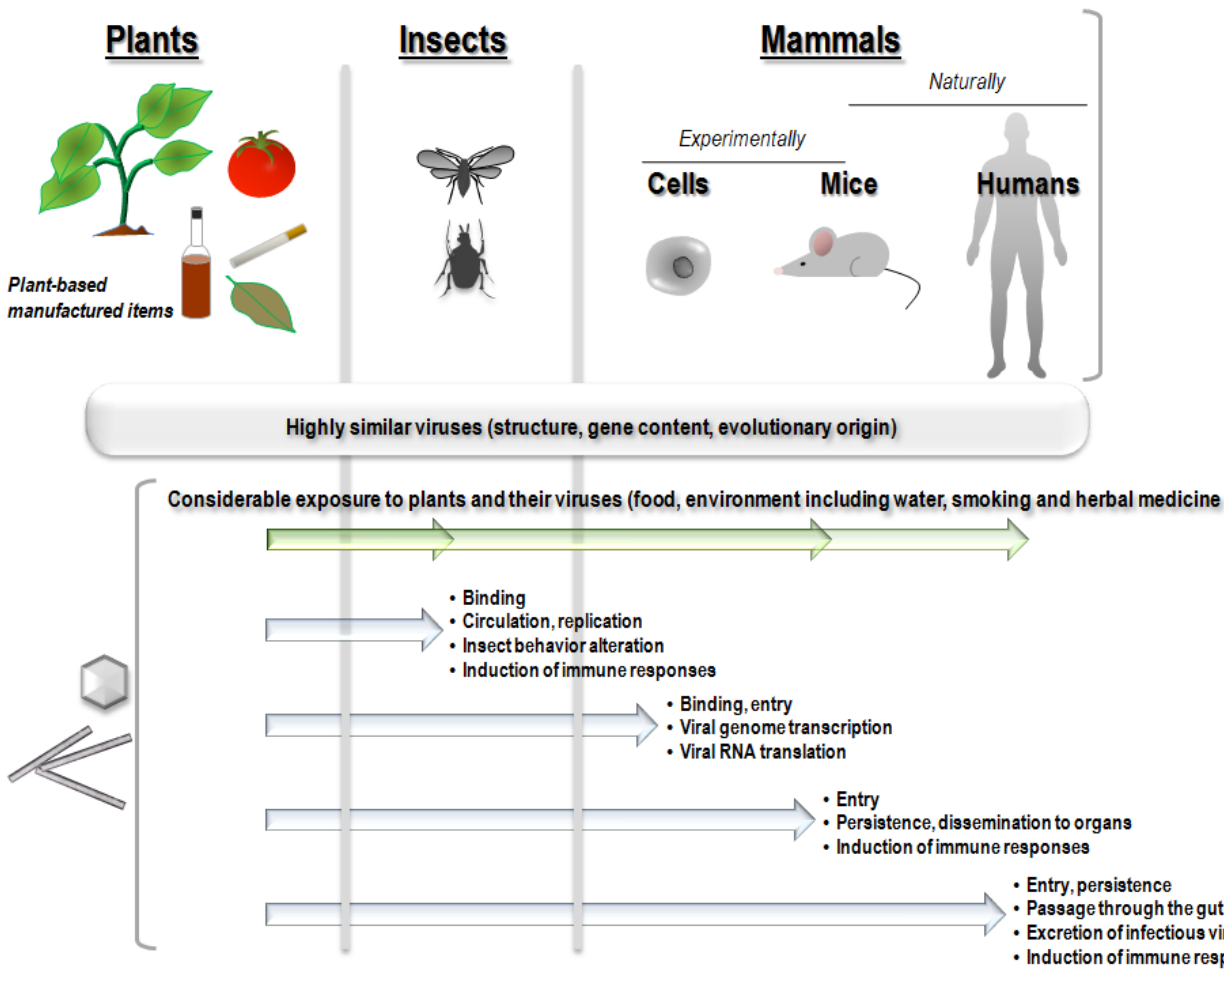
Figure 1. Summary of findings that support border crossing for plant viruses into the invertebrate and vertebrate